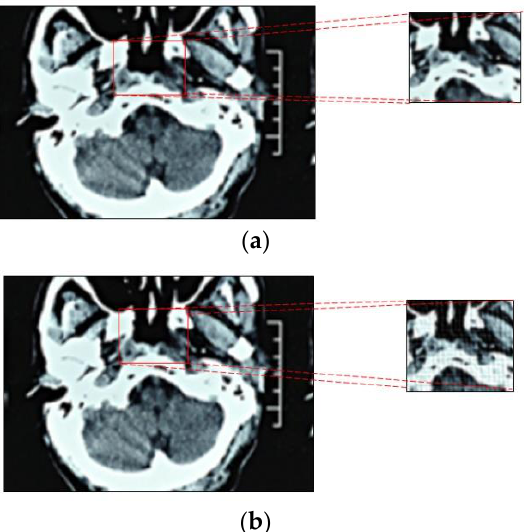
Figure 4. ( a ) Noisy CT image; ( b ) denoised CT image based on proposed method.